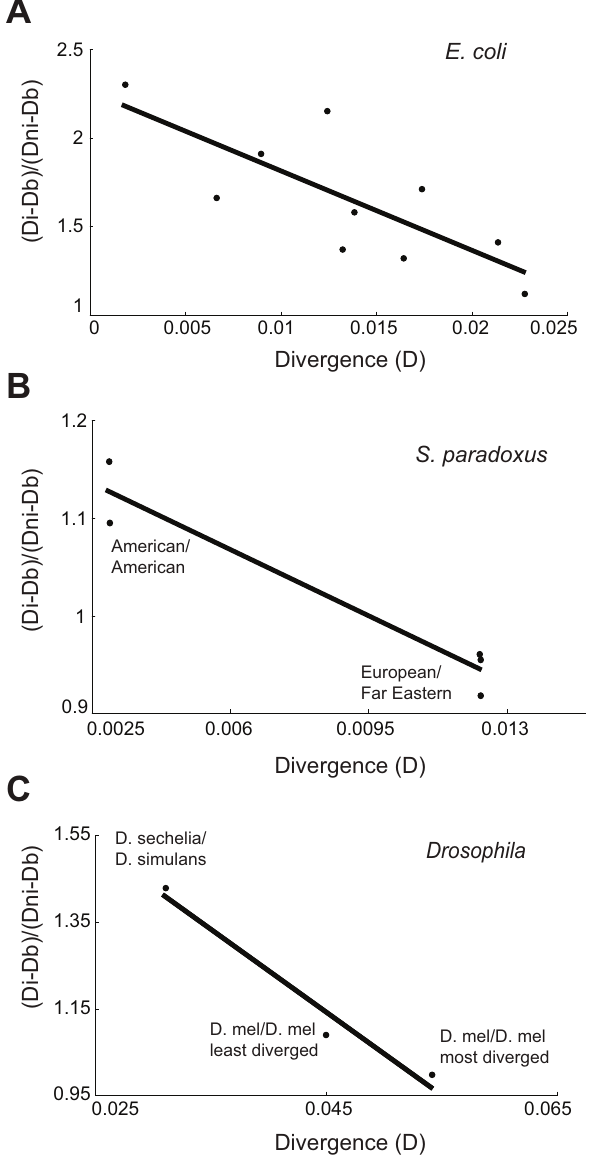
Figure 4. The proportion of D attributable to the indel decreases after the indel event. The indels found in comparisons between highly similar strains have a higher proportion of the nucleotide diversity attributable to the indel effect than sets of indels uncovered by pairwise comparisons of progressively more diverged strains for (A) E. coli (Pearson’s correlation coefficient, r = 2 0.769, p = 0.00933), (B) S. paradoxus (Pearson’s correlation coefficient, r = 2 0.963, p =0.008), and (C) Drosophila (Pearson’s correlation coeffi- cient, r = 2 0.980, p =0.128). Note that the pair D. simulans / D. sechelia is less diverged than the D. melanogastor / D. melanogastor comparisons because strains used for the latter were inbred with balancer chromosomes, allowing the accumulation of a large amount of mutations (see Materials and Methods). doi:10.1371/journal.pbio.1000622.g004 eukaryotes. However, a consistent decrease in Di/Dni is found across taxonomic kingdoms, an observation at odds with the